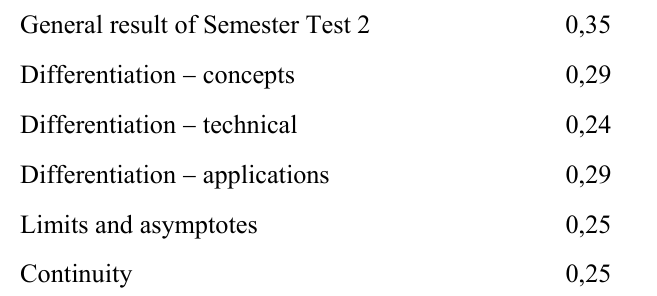
Table 3 : Correlation coefficients between performance